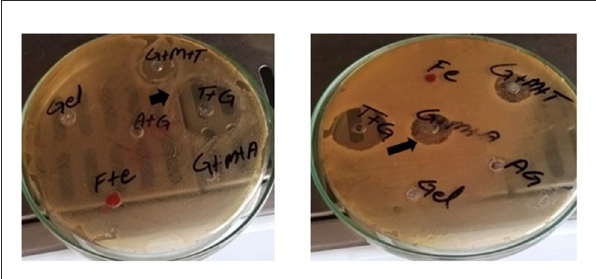
FIGURE1 Zone of inhibitions (black arrows) for different preparations against K. pneumoniae (left) and S. agalactiae (right)